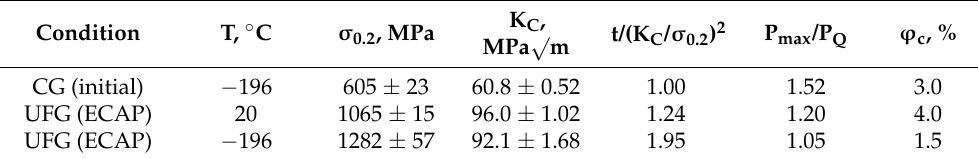
Table 3. Static crack resistance of the steel in different states and the criteria for the PS conditions to be realized according to GOST 25.506-85. Condition